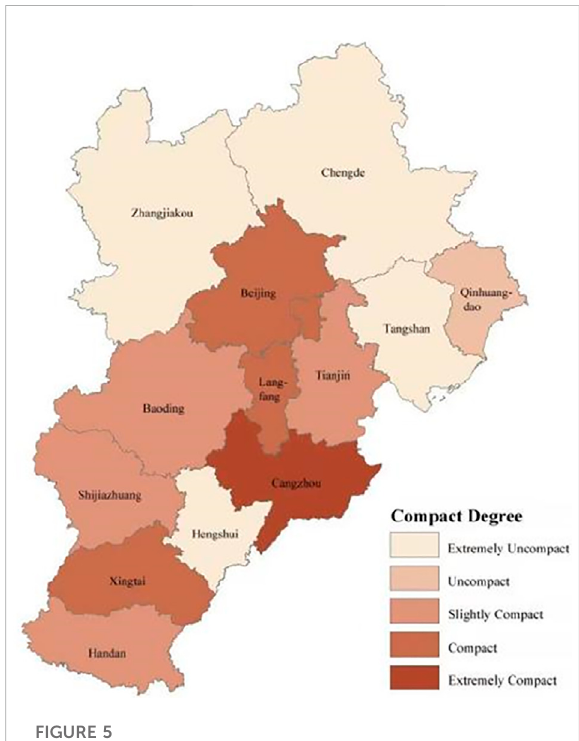
FIGURE 5 Degree of Compactness of living space in Beijing-Tianjin-